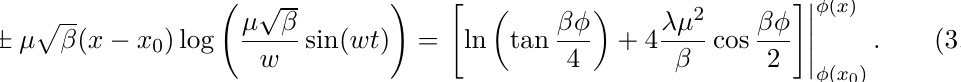
JHEP04(2021)106